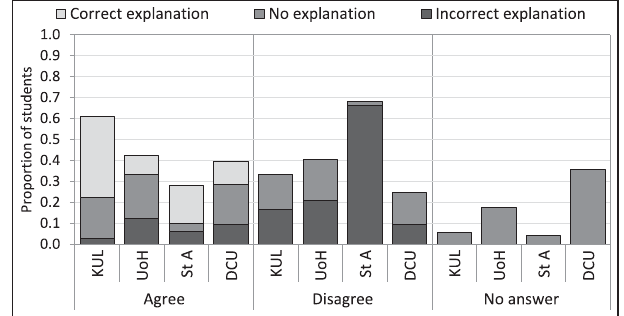
FIG. 5. Distribution of responses and corresponding argumen- tation to question 4(b) [Fig.